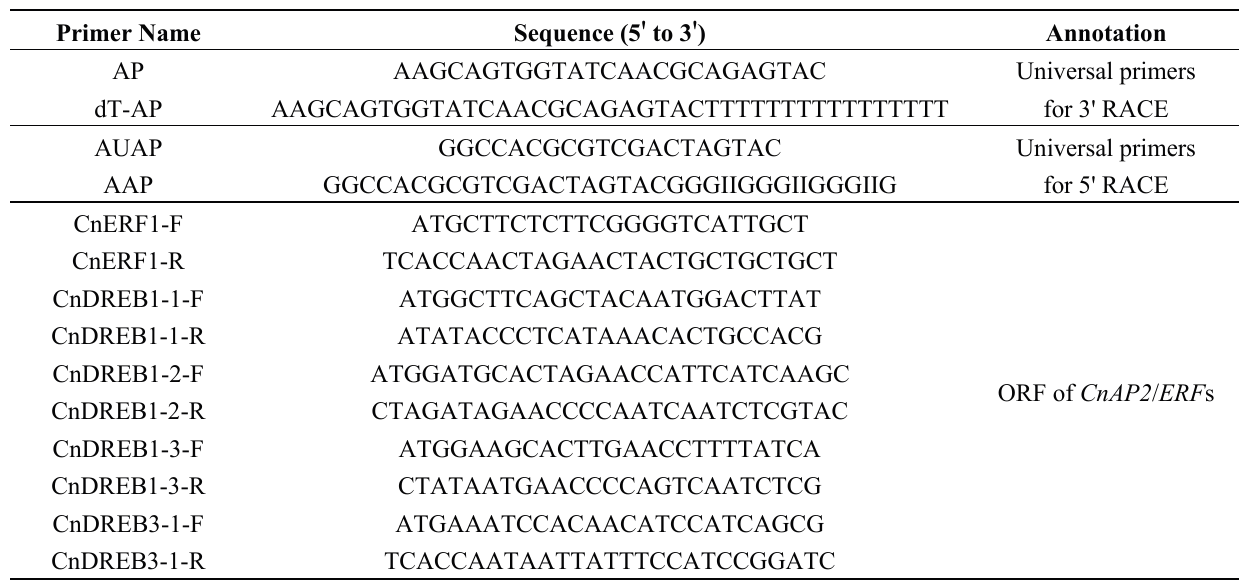
Table 2. PCR primer sequences utilized in this